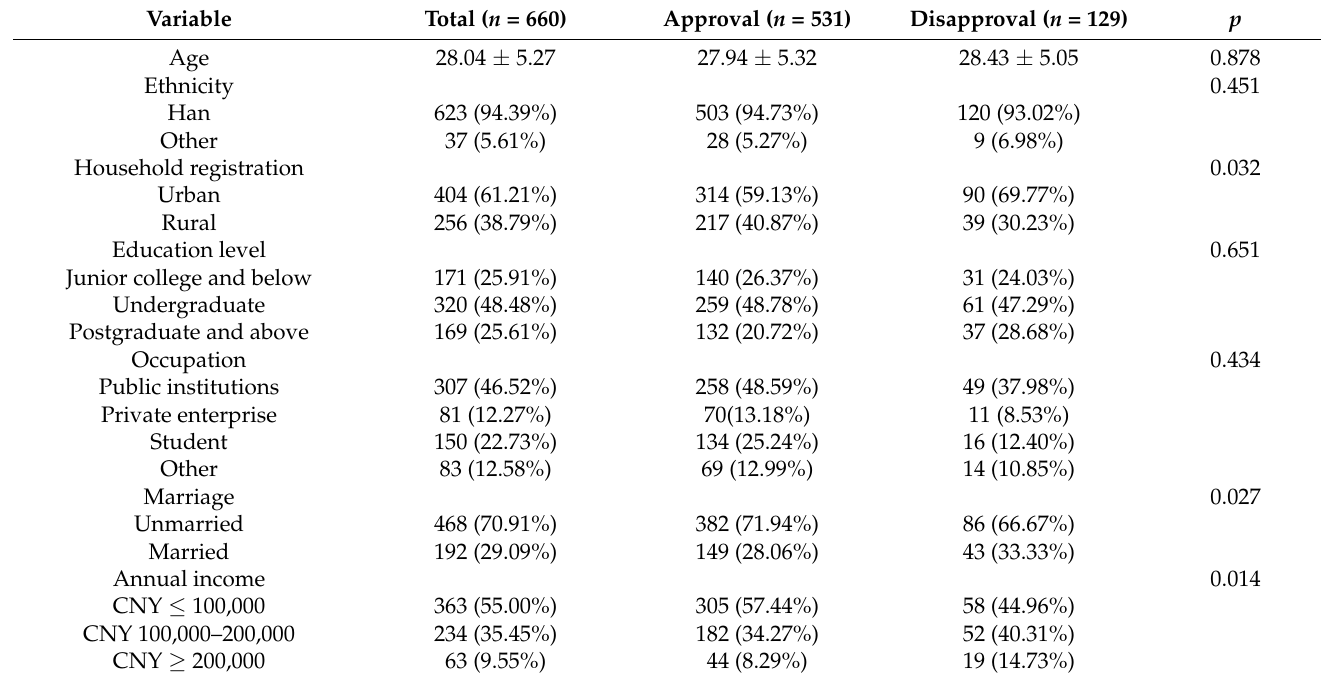
Table 1. Socioeconomic